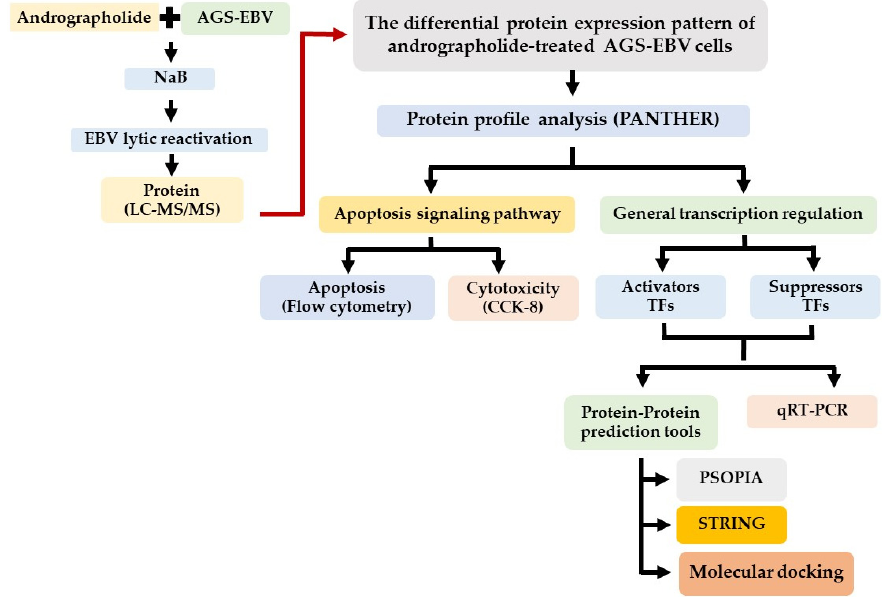
Figure 1. Schematic representation of experimental design.